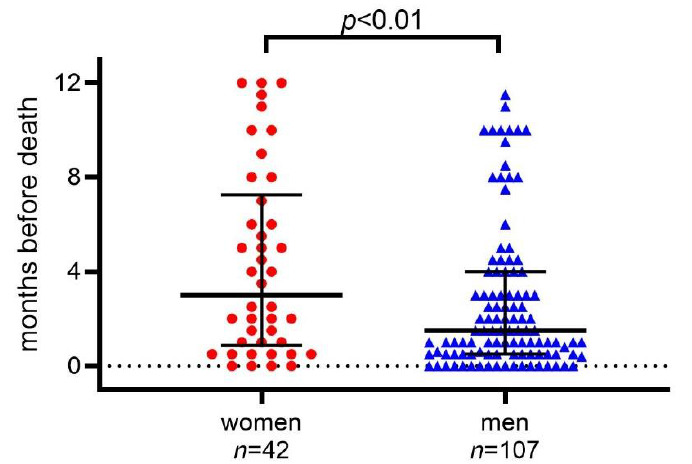
Figure 1. Time-point for statin termination during the year before death in 149 cancer patients admitted to Palliative Home Care. Lines show median and interquartile range.